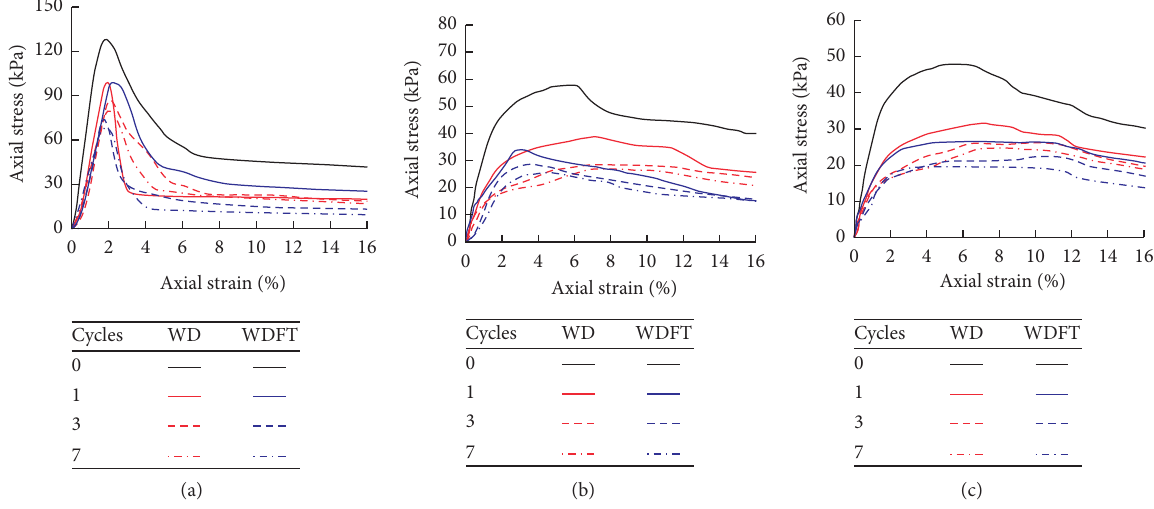
Figure 12: Curves of stress-strain relationships. (a) Dry range I. (b) Dry range II. (c) Dry range III.